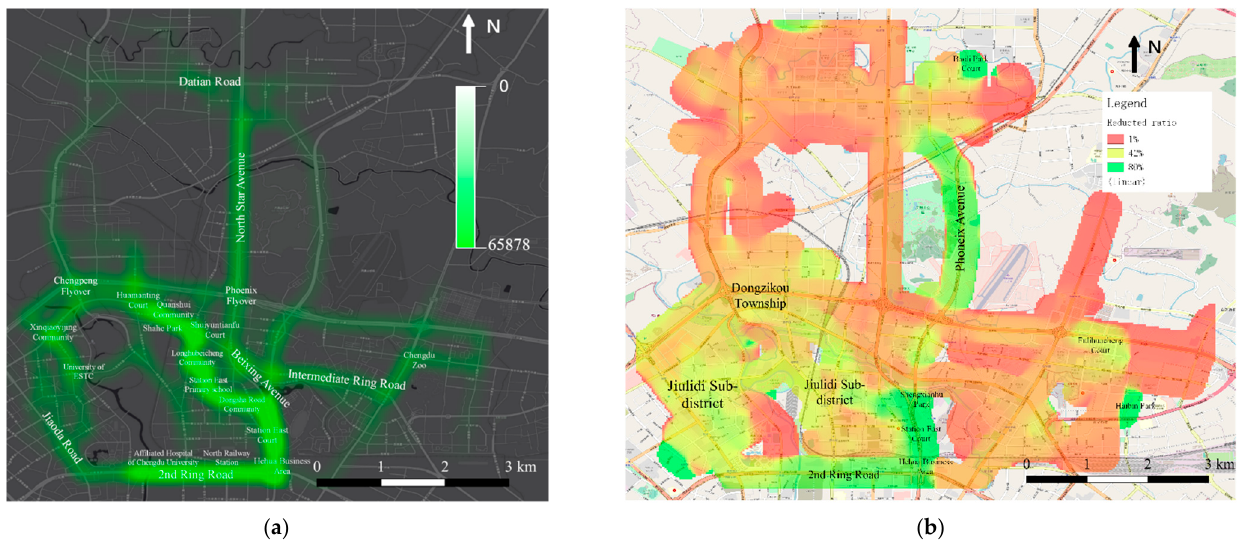
Figure 13. Spatial distribution of reduced emissions by setting up the shuttle service. ( a ) Spatial kernel density of reduced emission; ( b ) spatial distribution of reduced emission ratio.